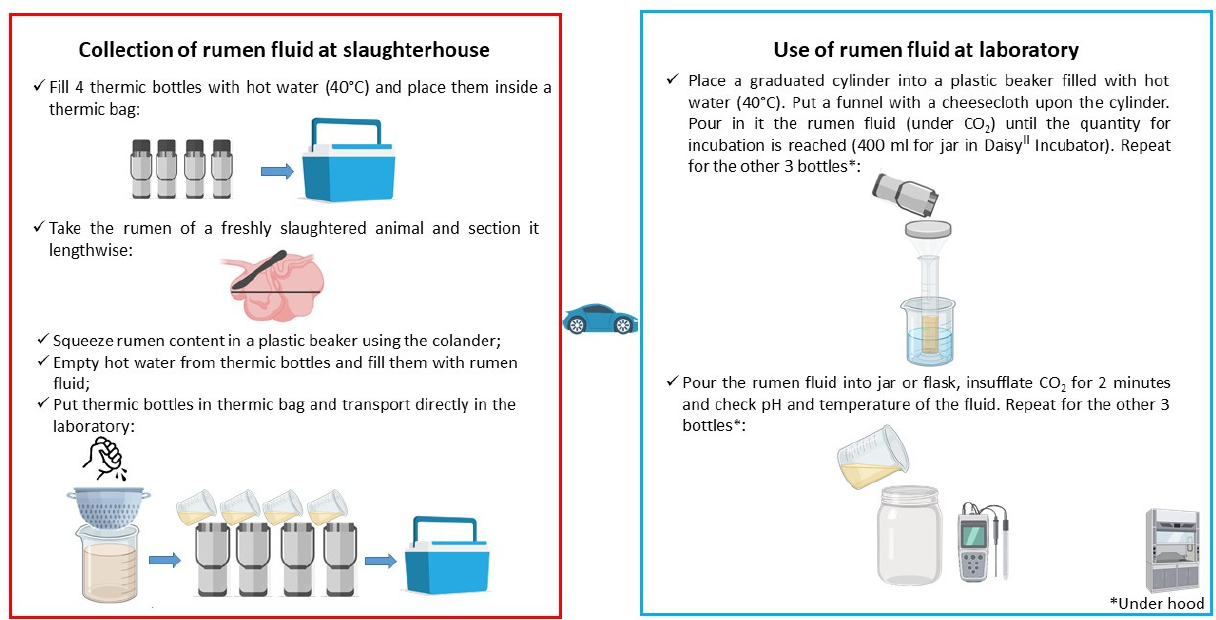
Figure 6. RF collection and storage procedure for in vitro digestibility